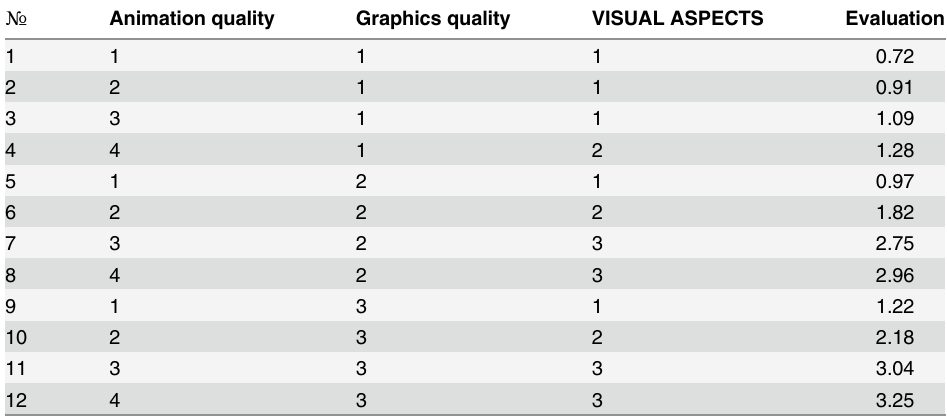
Table 4. From qualitative to quantitative evaluations using QQ method. The complete data-set is given in S1 DSS Implementation.